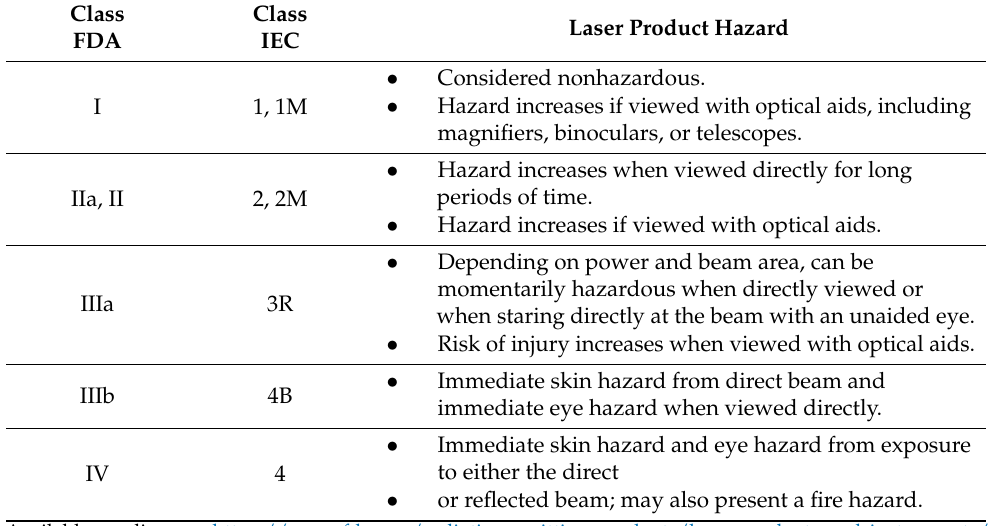
Table 1. Laser Hazard